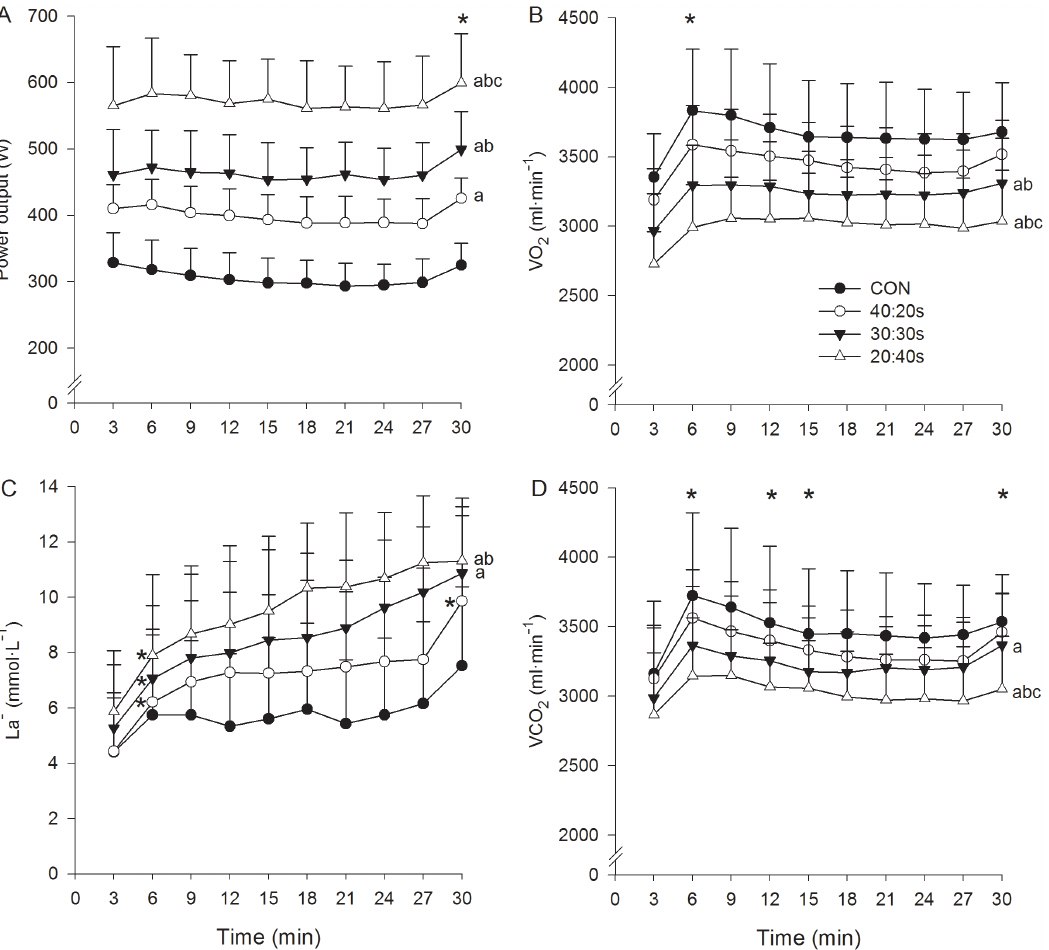
Figure 2. Power output, blood lactate and gas exchange parameters. Power output (work phase only in INT) (A), VO 2 (B), blood lactate (C) and VCO 2 (D) for CON (closed circles), 40:20s (open circles), 30:30s (closed triangles) and 20:40s (open triangles). Data points for gas exchange parameters result from a three minute average, including also the recovery periods in INT. Letters (a, b and c) report main effect of protocol. (a) P , 0.05 vs. CON. (b) P , 0.05 vs. 40:20s. (c) P , 0.05 vs. 30:30s. Asterisks in the upper part of each graph report main effect of time, while asterisks near a data point indicate protocol by time interaction (found for La 2 ). * P , 0.05 vs. the previous value. specific physiological responses, contrasting previous observations